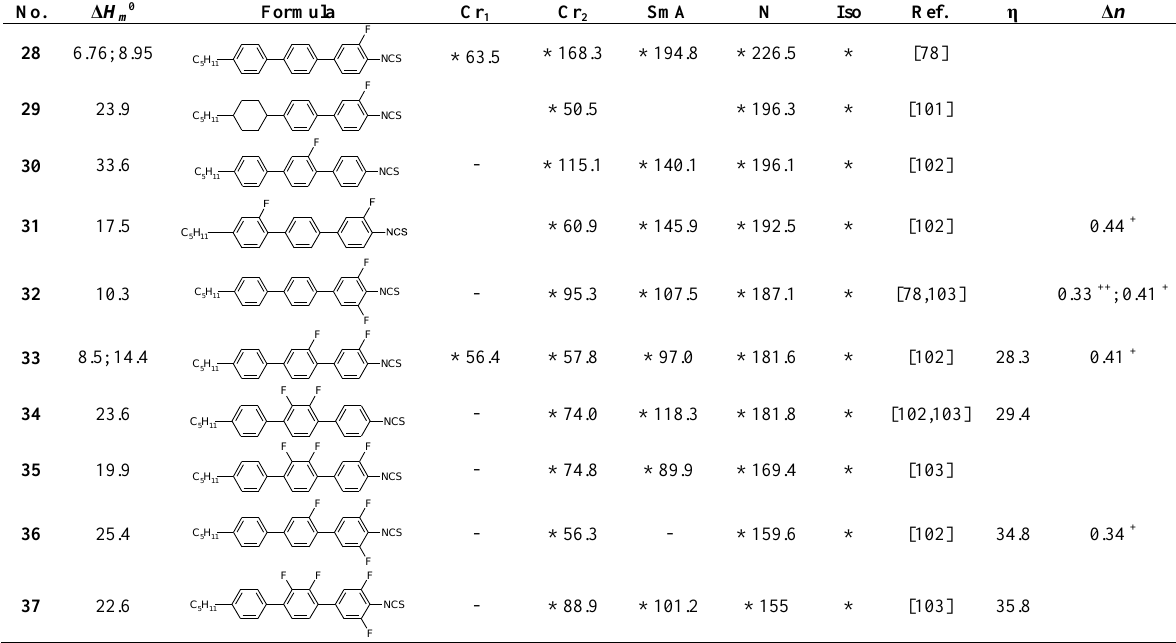
Table 6. Phase transitions temperatures [°C], melting enthalpies [kJ/mol], birefringence and bulk viscosity [mPa∙s] of 4ʺ-alkyl-4-isothiocyanatoterphenyls.